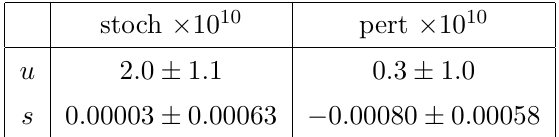
Table 5 . Correlated di(cid:11)erence of results obtained from using equation (5.11) or Pad(cid:19)e R 11 for determining ^(cid:5)( ^ Q 2 ).